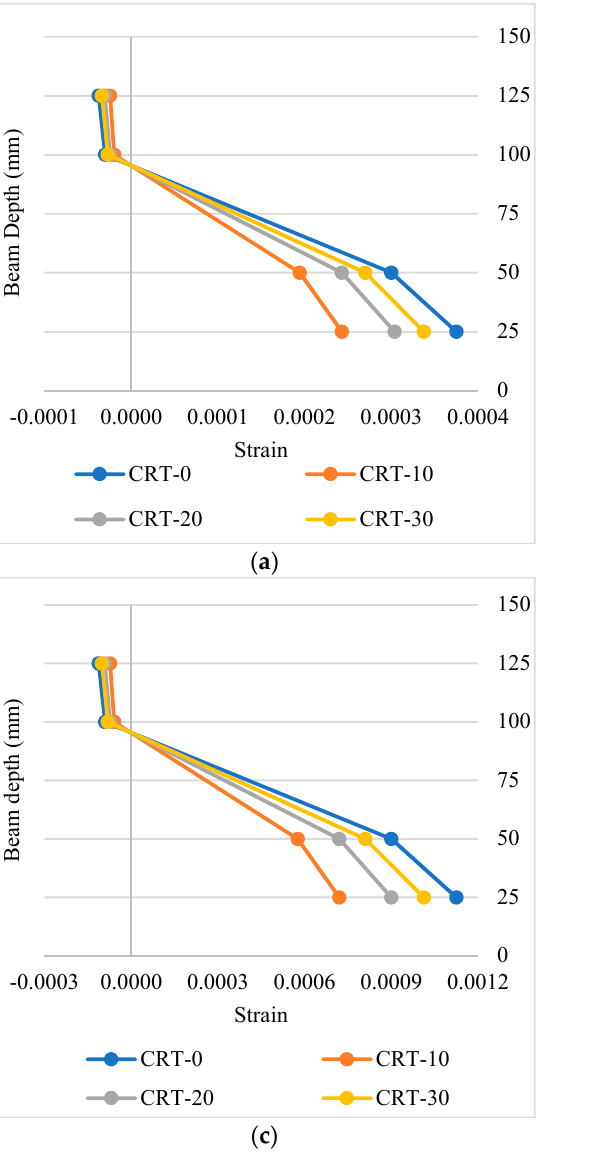
Figure 9. Strain distribution for all beams at ( a ) 8 kN ( b ) 16 kN ( c ) 24 kN and ( d ) 32 kN. The failure mode and crack propagation of the beams is shown in Figure 10a–d for beams with 0%, 10%, 20%, and 30% CRT glass. As expected, cracks developed in the ten- sile zone and propagated vertically upwards, mainly in the middle part of the beam. This